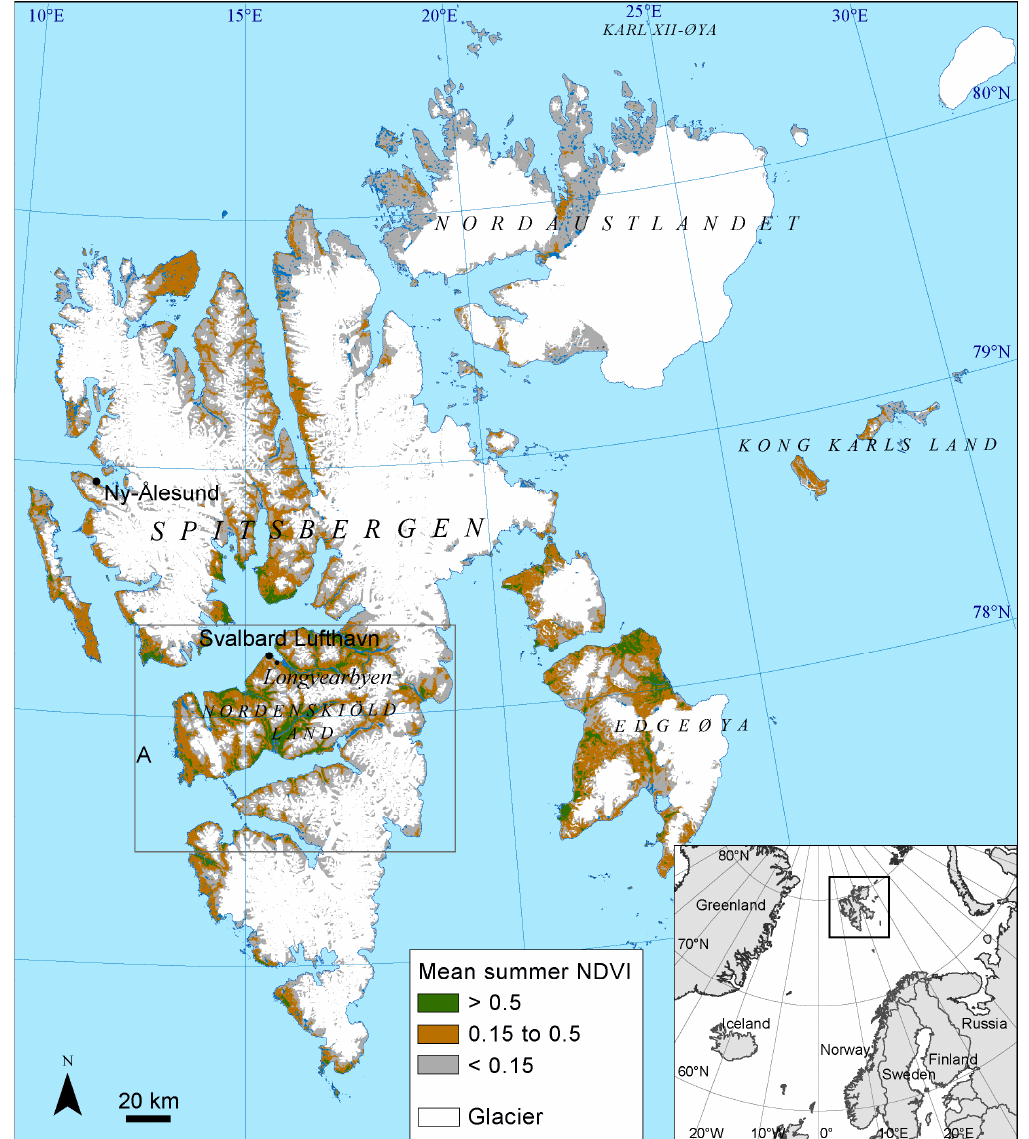
Figure 1. The study area of Svalbard, showing mean NDVI values for the 25 July to 1 August period (MODIS Terra 21-year, mean 2000–2020), and the location of the meteorological stations Svalbard Lufthavn and Ny-Ålesund. Glaciers are from the Svalbard S250 dataset. ‘A’ indicates the area recently mapped by using time series of Sentinel-2 data [16]. Table 1. Monthly and mean annual temperature ( ◦ C) for the two meteorological stations Svalbard Lufthavn and Ny-Ålesund based on data from the Norwegian Centre for Climate Services [15]. Temperatures for the period 2000–2020 were analyzed, and, assuming a linear trend, ** p < 0.01, * p <